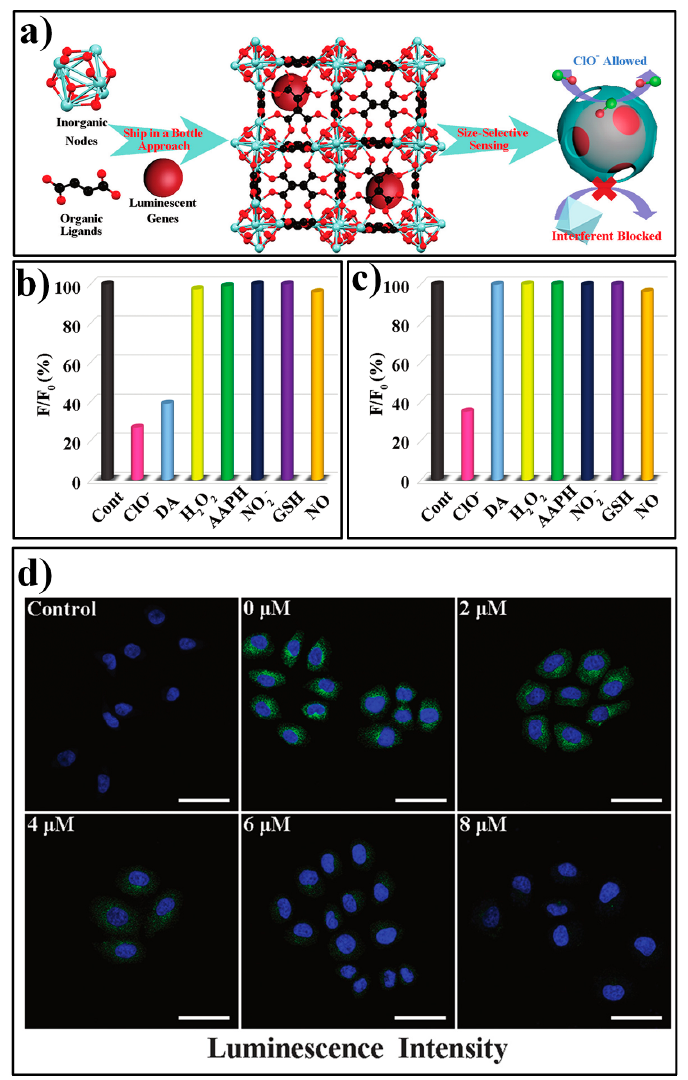
Figure 15. ( a ) Schematic illustration of the synthetic procedure for AF@MOF-801 and the size-selective sensing mechanism toward targe analyte of ClO − . ( b ) The luminescence responses of free AF for various analytes. ( c ) The luminescence responses of AF@MOF-801 for various analytes. ( d ) The confocal laser scanning microscopy images of SMMC-7721 cells incubated with AF@MOF-801 and with